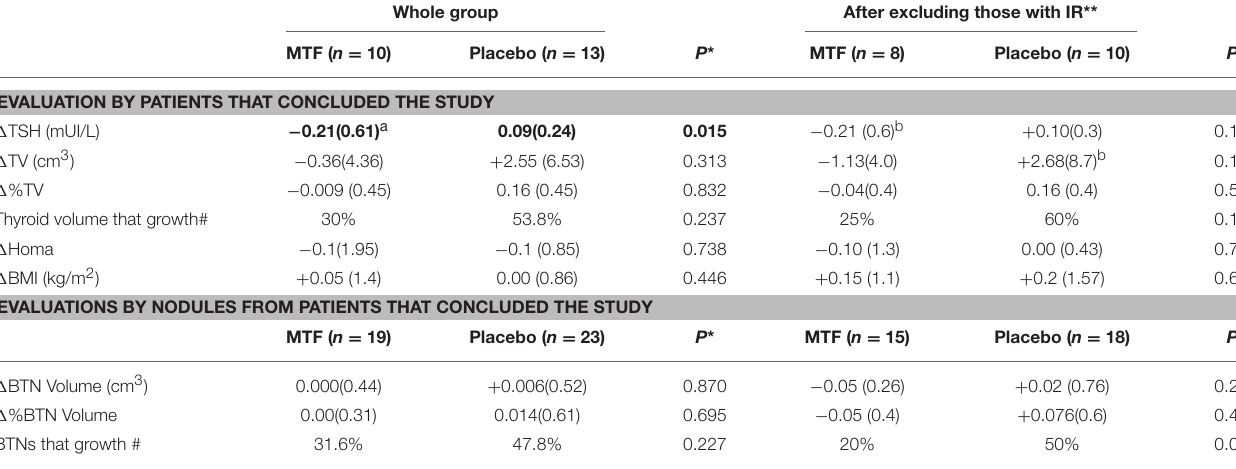
TABLE 2 | Comparisons between outcome variables in MTF and Placebo groups during the study. Whole group After excluding those with IR** MTF ( n = 10) Placebo ( n = 13) P * MTF ( n = 8) Placebo ( n = 10) P